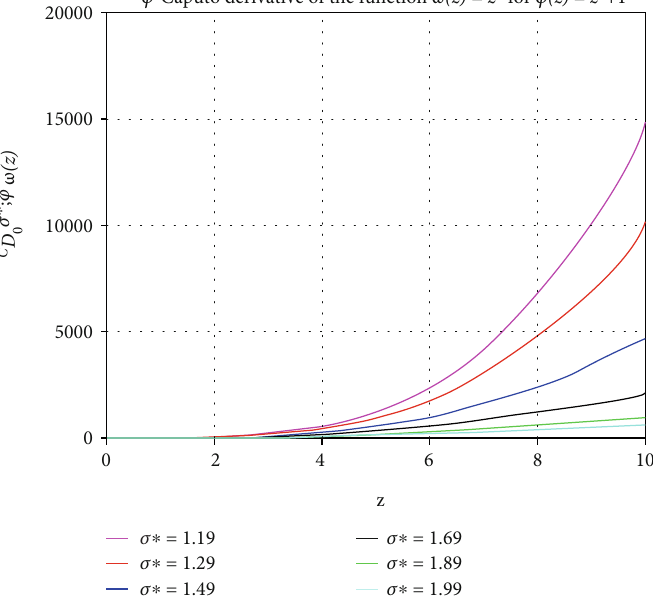
Figure 1: The CapFr-derivative of ϖ ð z Þ = z 6 for φ ð z Þ = z 2 + 1 :